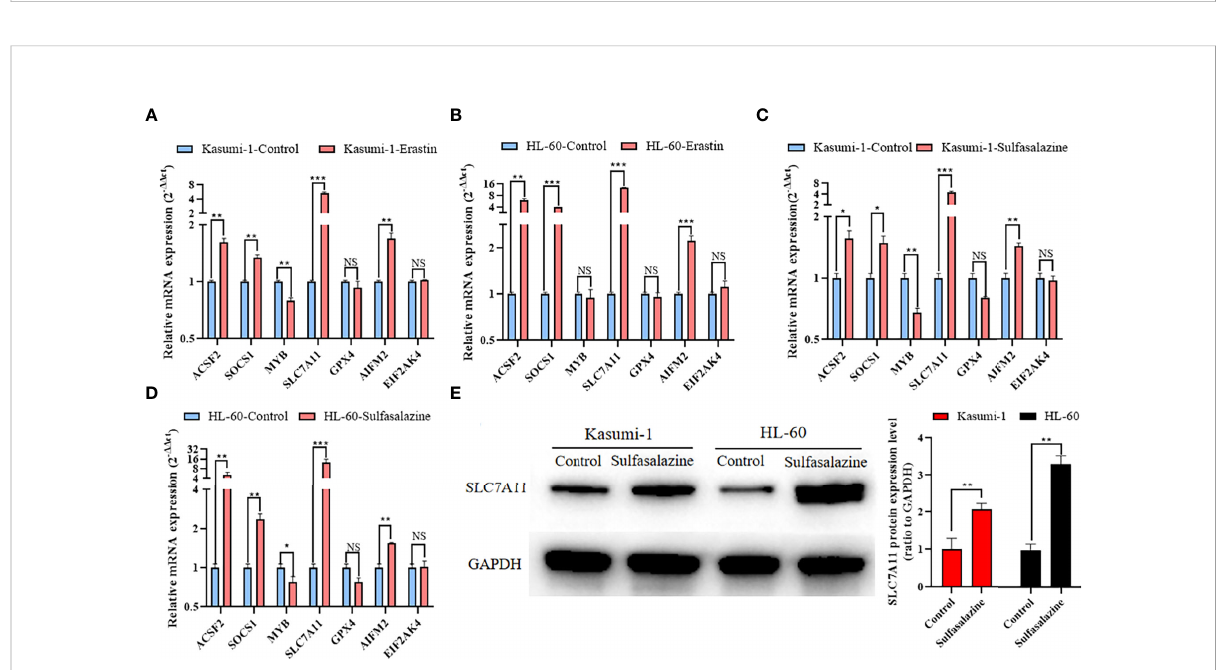
FIGURE 8 Expression of 7 prognostic ferroptosis-related genes in Kasumi-1 and HL-60 cells after 24 h treatment with 5 µM erastin and 300 µM sulfasalazine. qRT-PCR detection of mRNA expression levels of seven prognostic ferroptosis-related genes in (A, C) Kasumi-1 and (B, D) HL-60 cells treated with 5 mM erastin or 300 mM sulfasalazine. (E) SLC7A11 protein expression level in Kasumi-1 and HL-60 cells cultured for 24 hours under normal or 300 µM sulfasalazine treatment conditions. GAPDH mRNA and protein expressions were used as the loading control for qRT- PCR and Western blot. NS: not signi fi cant; * P < 0.05; ** P < 0.01; *** P < 0.001.